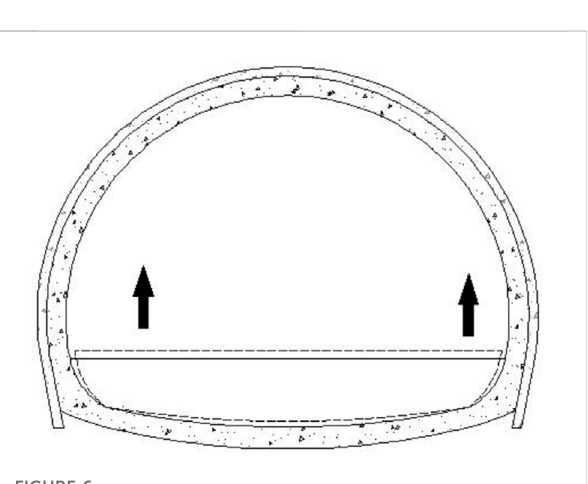
FIGURE 6 Failure of inverted arch fl oor heave (Schematic